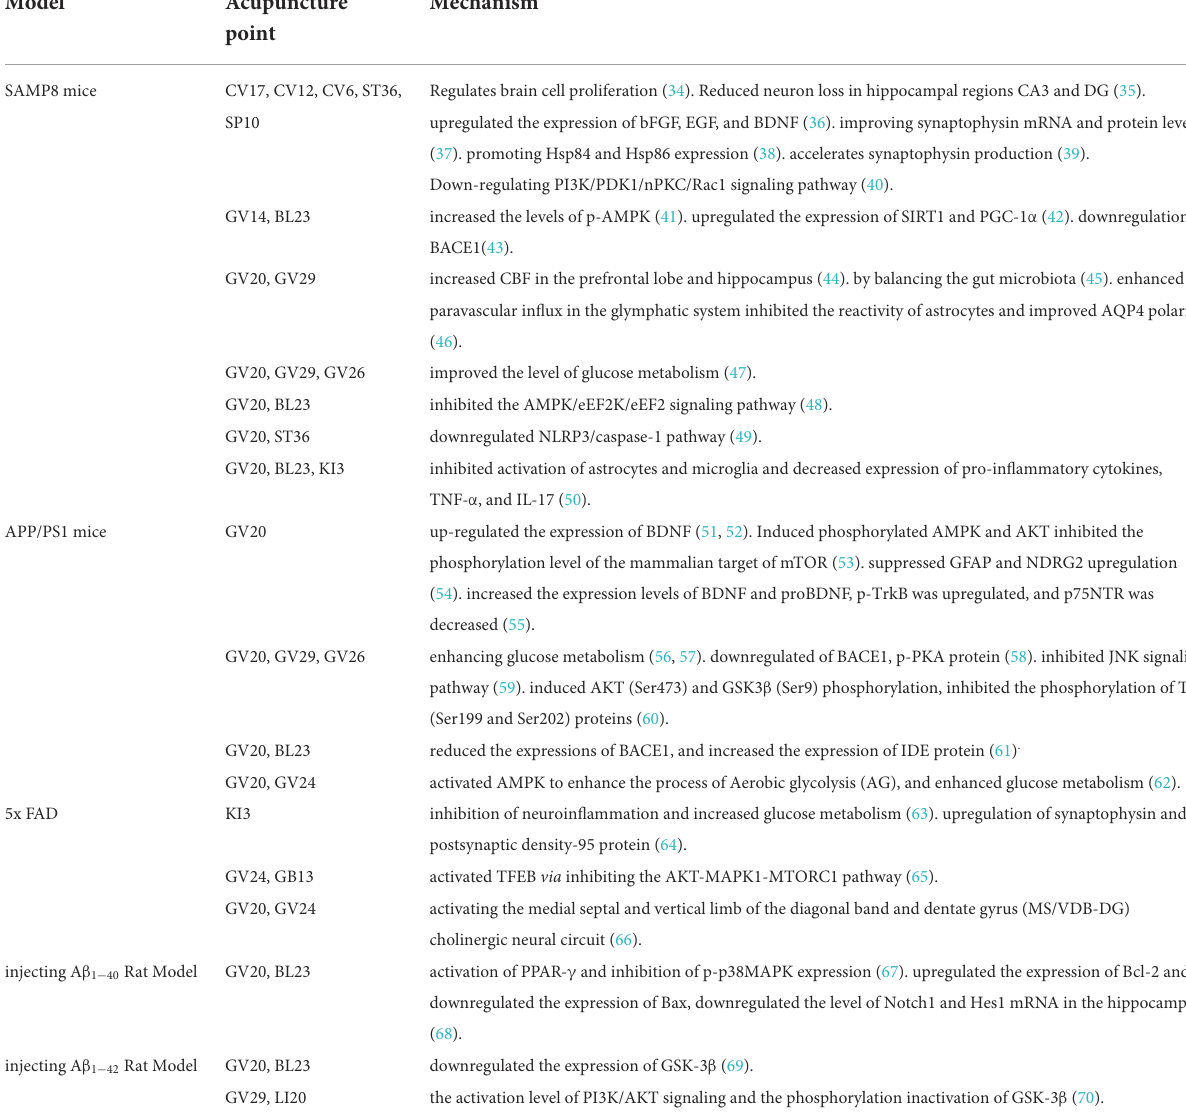
TABLE 6 The putative mechanisms of acupuncture on different Alzheimer’s disease animal